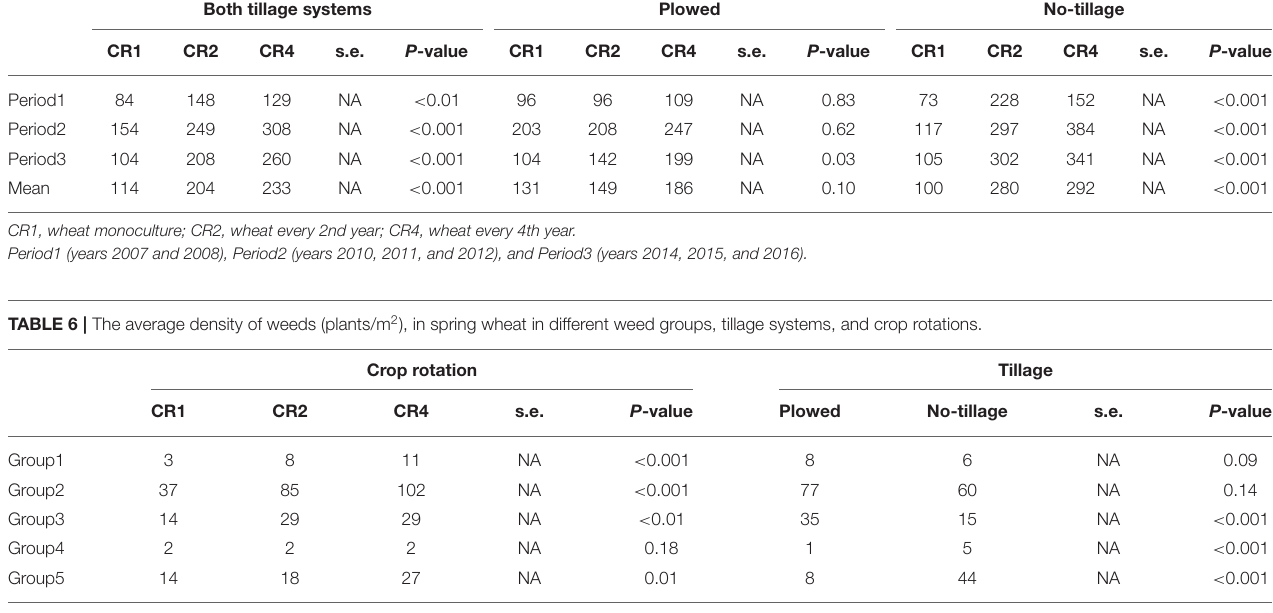
TABLE 5 | The average density of weeds (plants/m 2 ), in spring wheat in different tillage systems, time periods, and crop rotations. Both tillage systems Plowed No-tillage